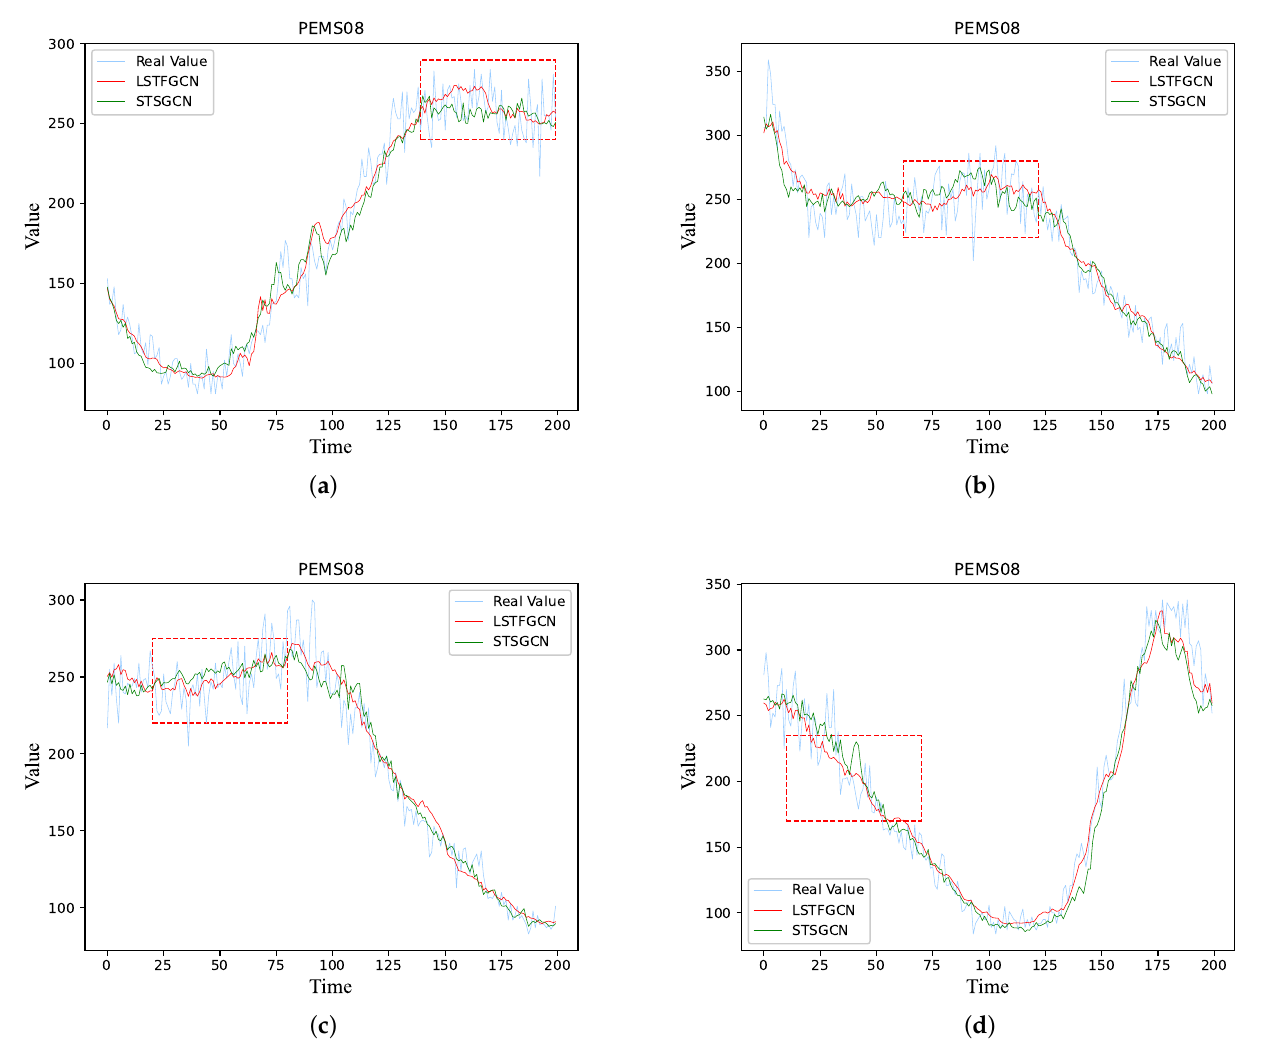
Figure 10. Comparison of prediction results of LSTFGCN and STSGCN in four random test cases ahead of Horizon 12 on PEMS08